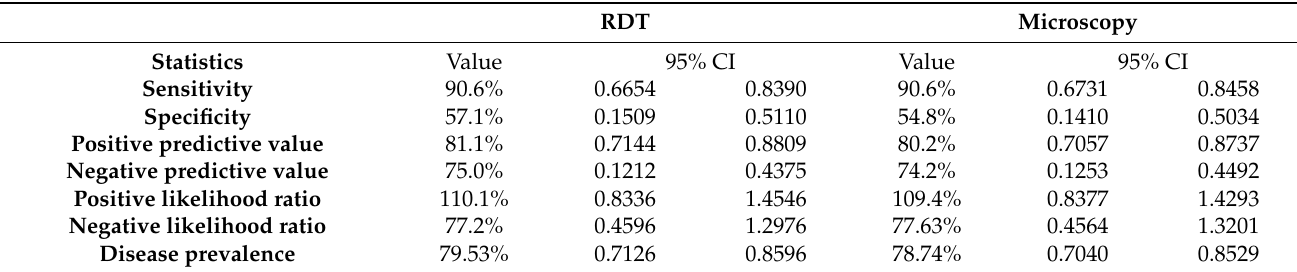
Table 5. Sensitivity and specificity and negative and positive predictive values of LM and the RDT (with the PCR as a reference method).